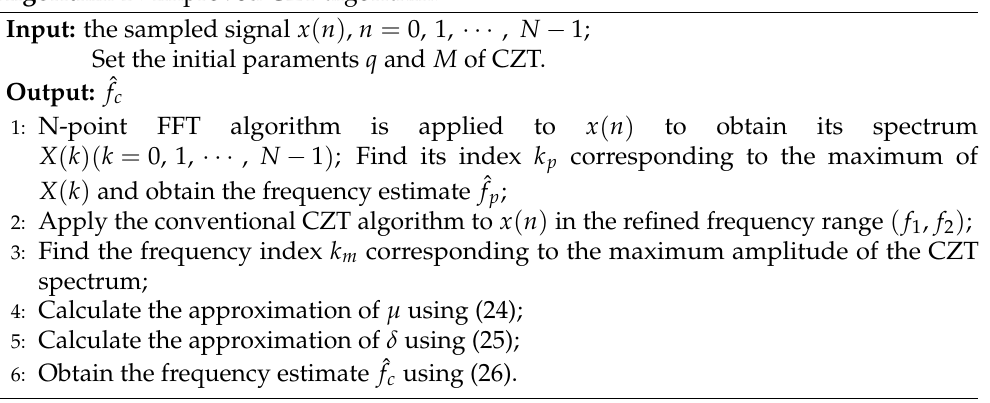
Algorithm 1 : Improved CZT algorithm.